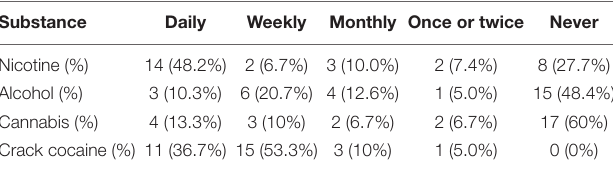
TABLE 2 | Frequency of drug use by crack cocaine-using mothers. Substance